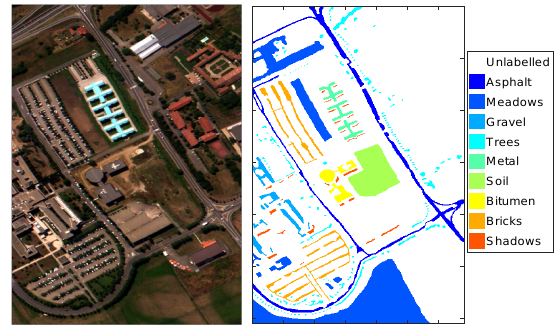
Figure 2. Three-band colour red (band No. 52), green (band No. 30), blue (band No. 10) composite of HSI for the University of Pavia ( left ); ground truth map ( right ): white area is not